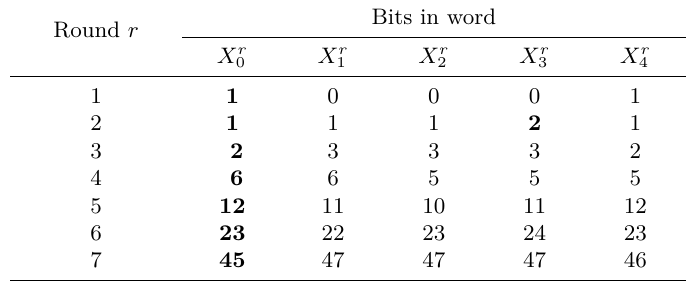
Table 3: Upper bounds on the algebraic degree of Ascon in cube variables Round